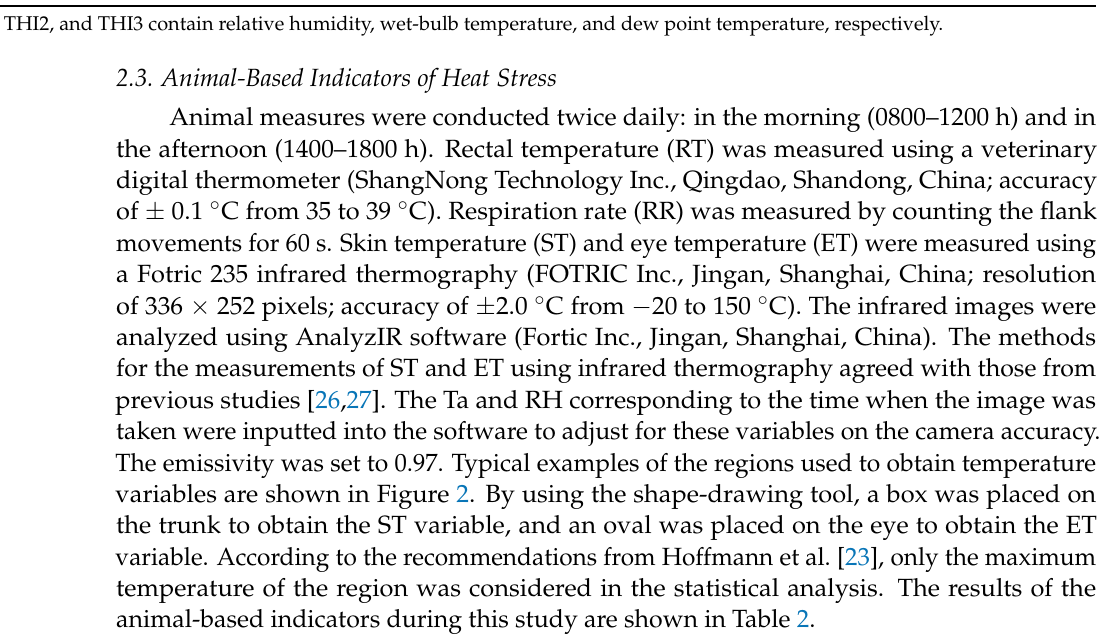
Table 1. Descriptive statistics for the environmental factors and thermal indices during this study.